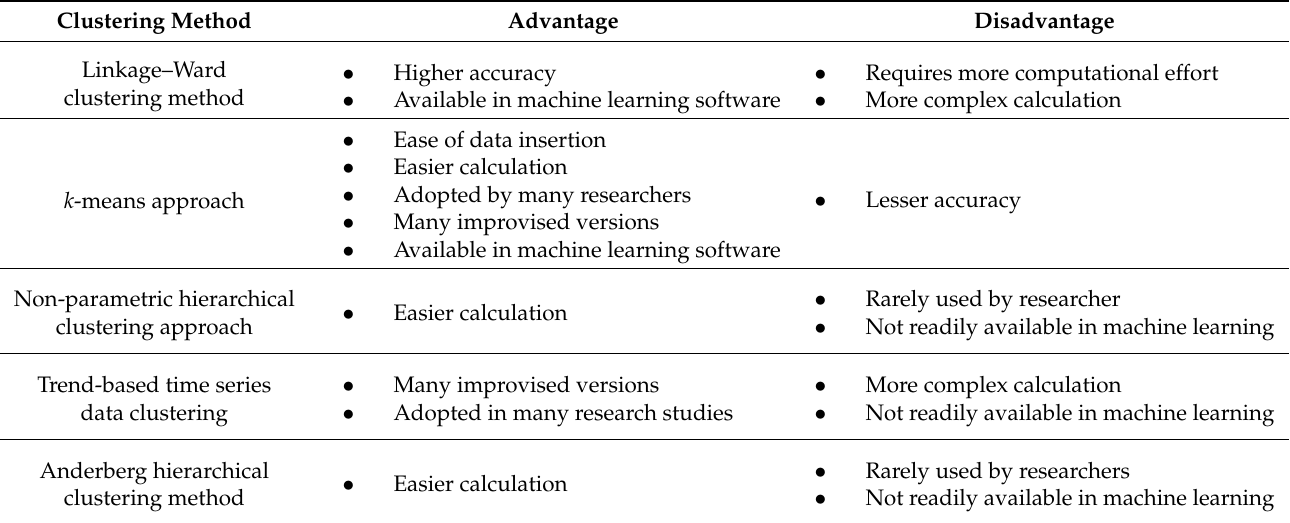
Table 10. Comparison table on clustering